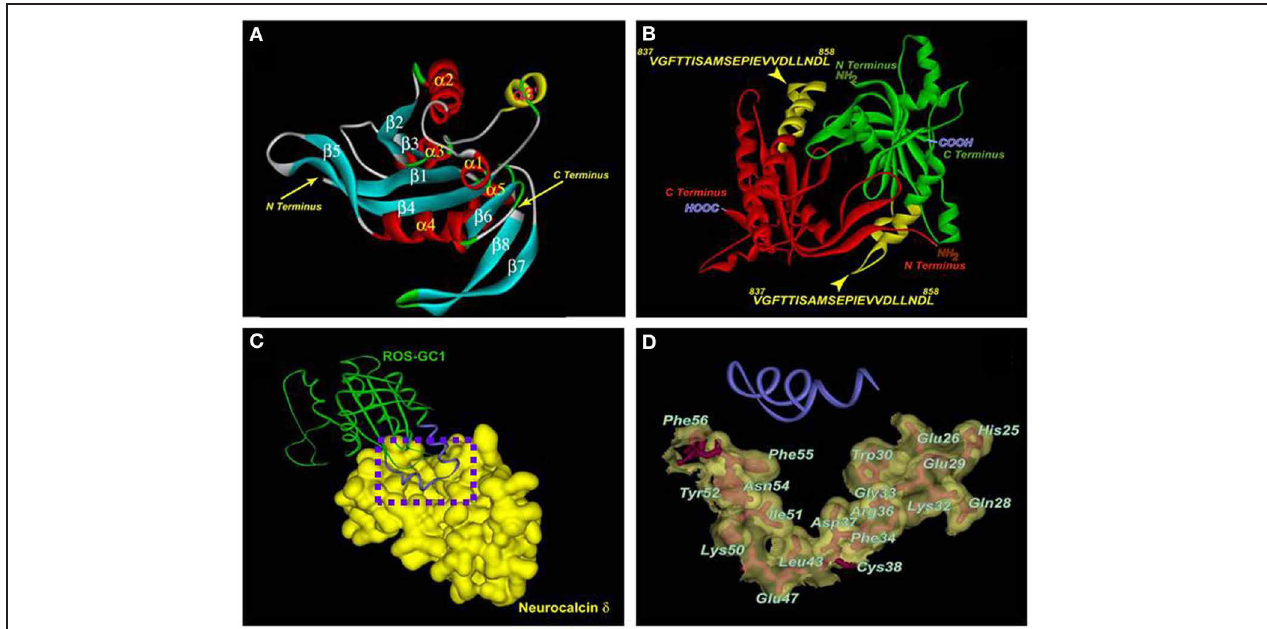
FIGURE 4 | Three-dimensional model of the ROS-GC1 catalytic domain and molecular docking of neurocalcin δ . (A) Ribbon diagram of the ROS-GC1 catalytic domain monomer. The α helices are shown in red and the β strands in cyan. Numbering is according to the protein data base file 1AZS template. The N- and C-termini are indicated by arrows. (B) The solvent-accessible V 837 -L 858 domain of ROS-GC1 catalytic domain. The two monomeric ROS-GC1 catalytic domains are indicated in red and green respectively. Within each monomer, the region corresponding to V 837 -L 858 is indicated in yellow and labeled. The N- and C-termini are labeled. (C) The ROS-GC1 catalytic domain/neurocalcin δ complex. Monomers of ROS-GC1 catalytic domain and of neurocalcin δ are depicted for clarity. ROS-GC1